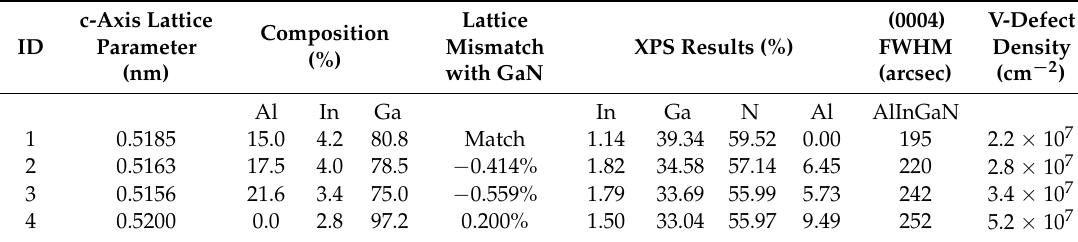
Table 2. Composition, (0004) full width at half maximum (FWHM) and V-defect density of samples. XPS: X-ray photoelectron spectroscopy.